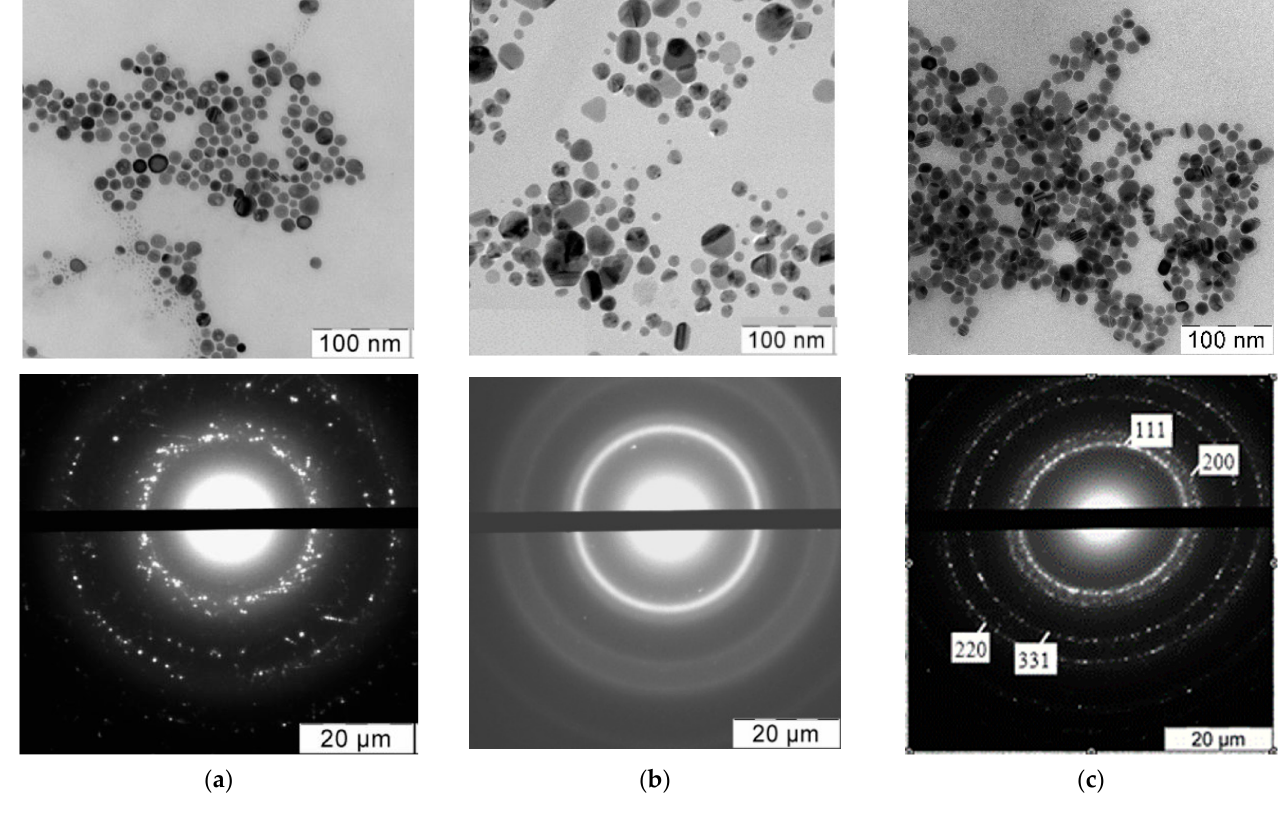
Figure 2. Typical electron microphotographs and X-ray diffraction patterns of ( a ) Ag/PHMB; ( b ) Ag/STAPCG; ( c ) Ag/SLES nanoparticles. Microphotographs and diffractograms of other nanoparticles were similar.